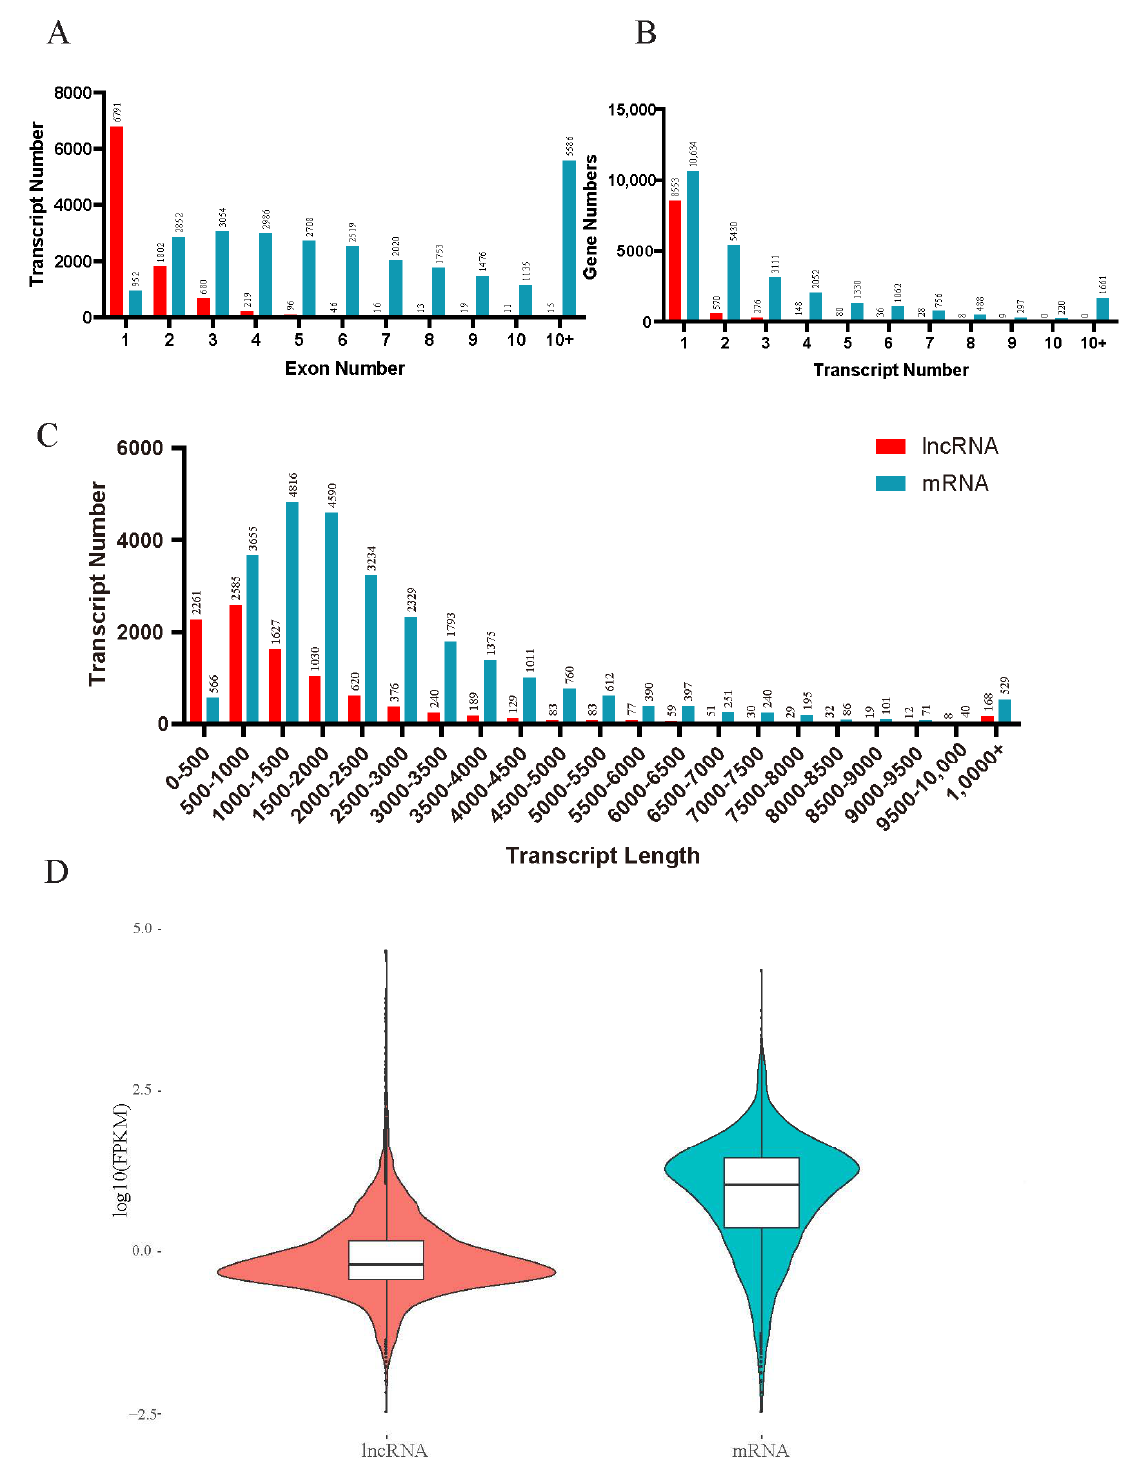
Figure 2. The proportion of exon number ( A ), transcript number ( B ), transcript length ( C ), and the violin diagram were used to compare the FPKM values of lncRNAs and mRNA ( D ). lncRNAs are shown in red, while light blue represents mRNAs.